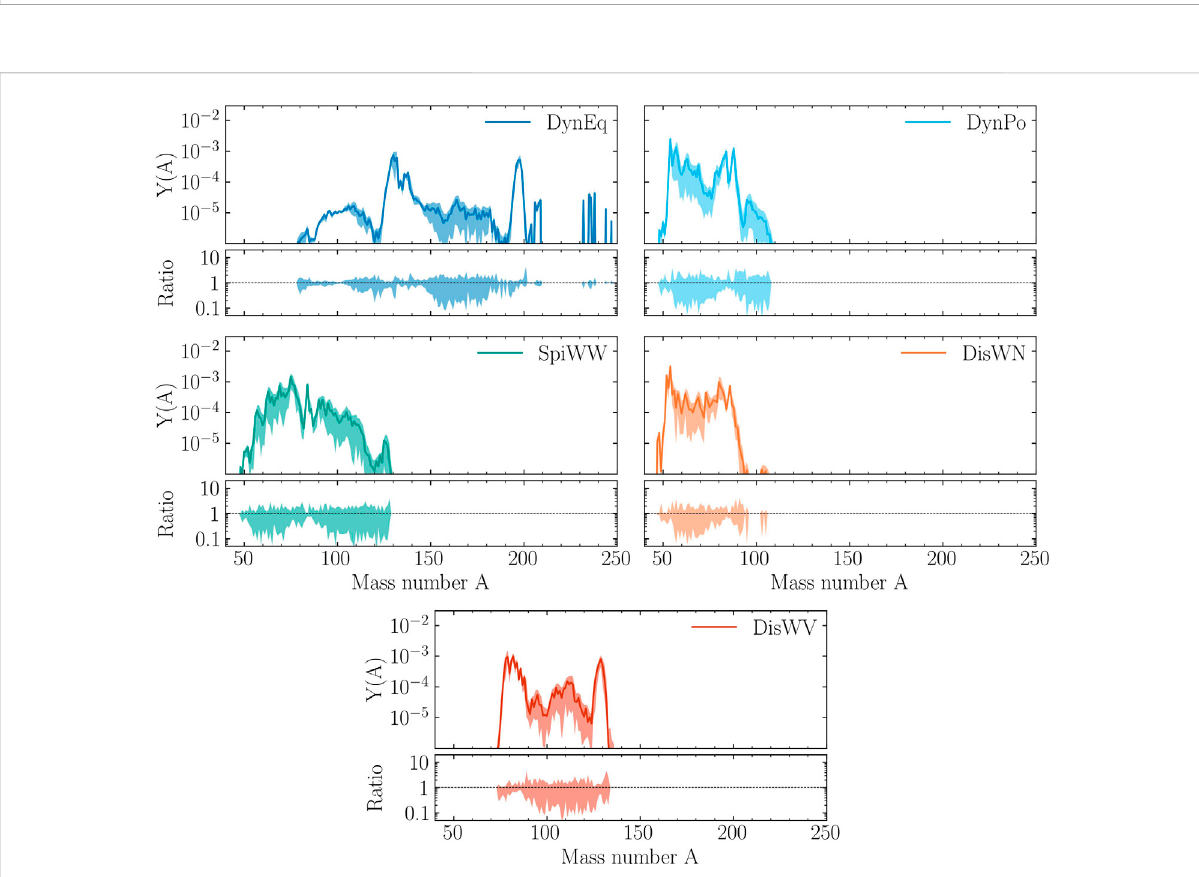
FIGURE 2 Upper panels: Variance in the isotopic abundance patterns (shaded bands), corresponding to the sensitivity studies for the different chosen trajectories. Lower panels: Ratio of fi nal abundances with respect to the baseline. Color code as shown in Figure